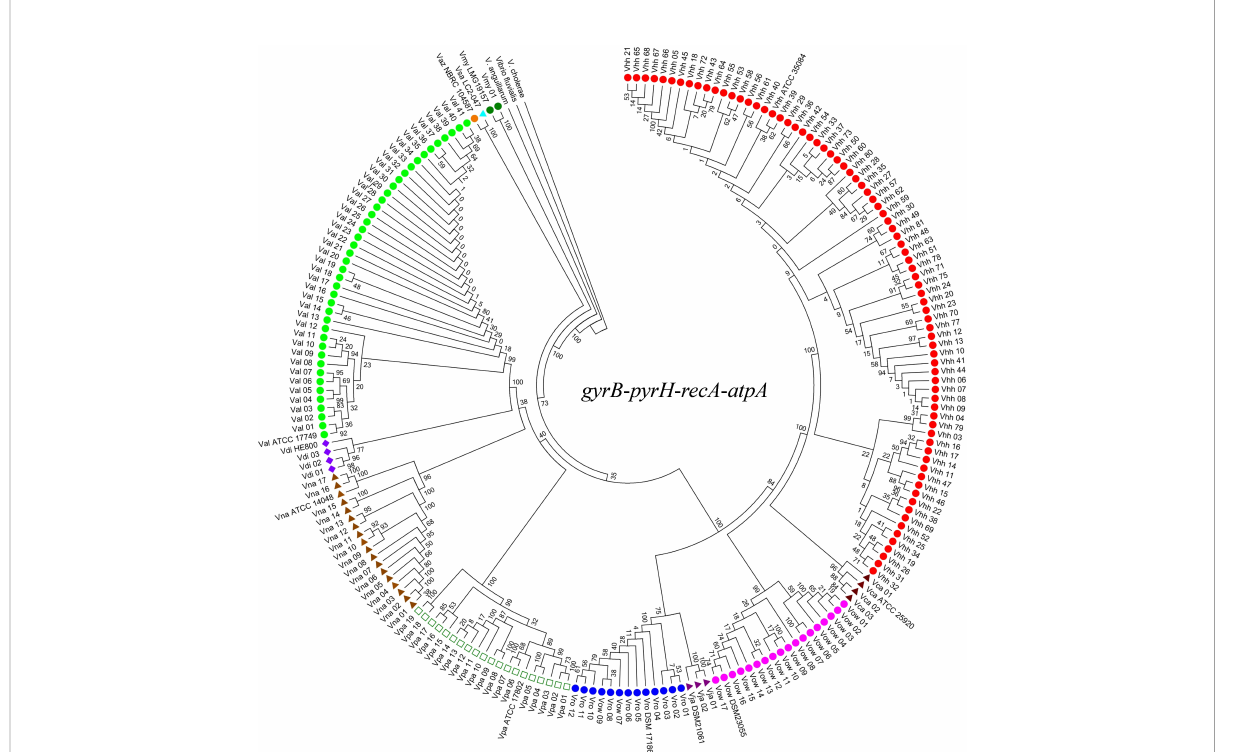
FIGURE 2 Neighbor-joining phylogenetic analysis based on concatenated gene sequences of four protein-coding loci (i.e., gyrB-pyrH-recA-atpA ). Vhh, V. harveyi ; Val, V. alginolyticus ; Vro, V. rotiferianus ; Vca, V. campbellii ; Vpa, V. parahaemolyticus ; Vow, V. owensii ; Vna, V. natriegens ; Vdi, V. diabolicus ; Vsa, V. sagamiensis ; Vaz, V. azureus ; Vja, V. jasicida ; Vmy, V. mytili . Bootstrap values based on 1,000 resamplings are shown as percentages at the branch